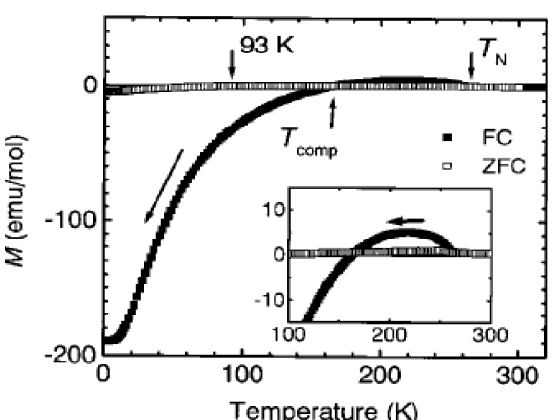
Fig. 4. FC and ZFC temperature dependent mag- netization curve for La the temperature area above 100K for FC curve. Re- produced from [19] with permission from